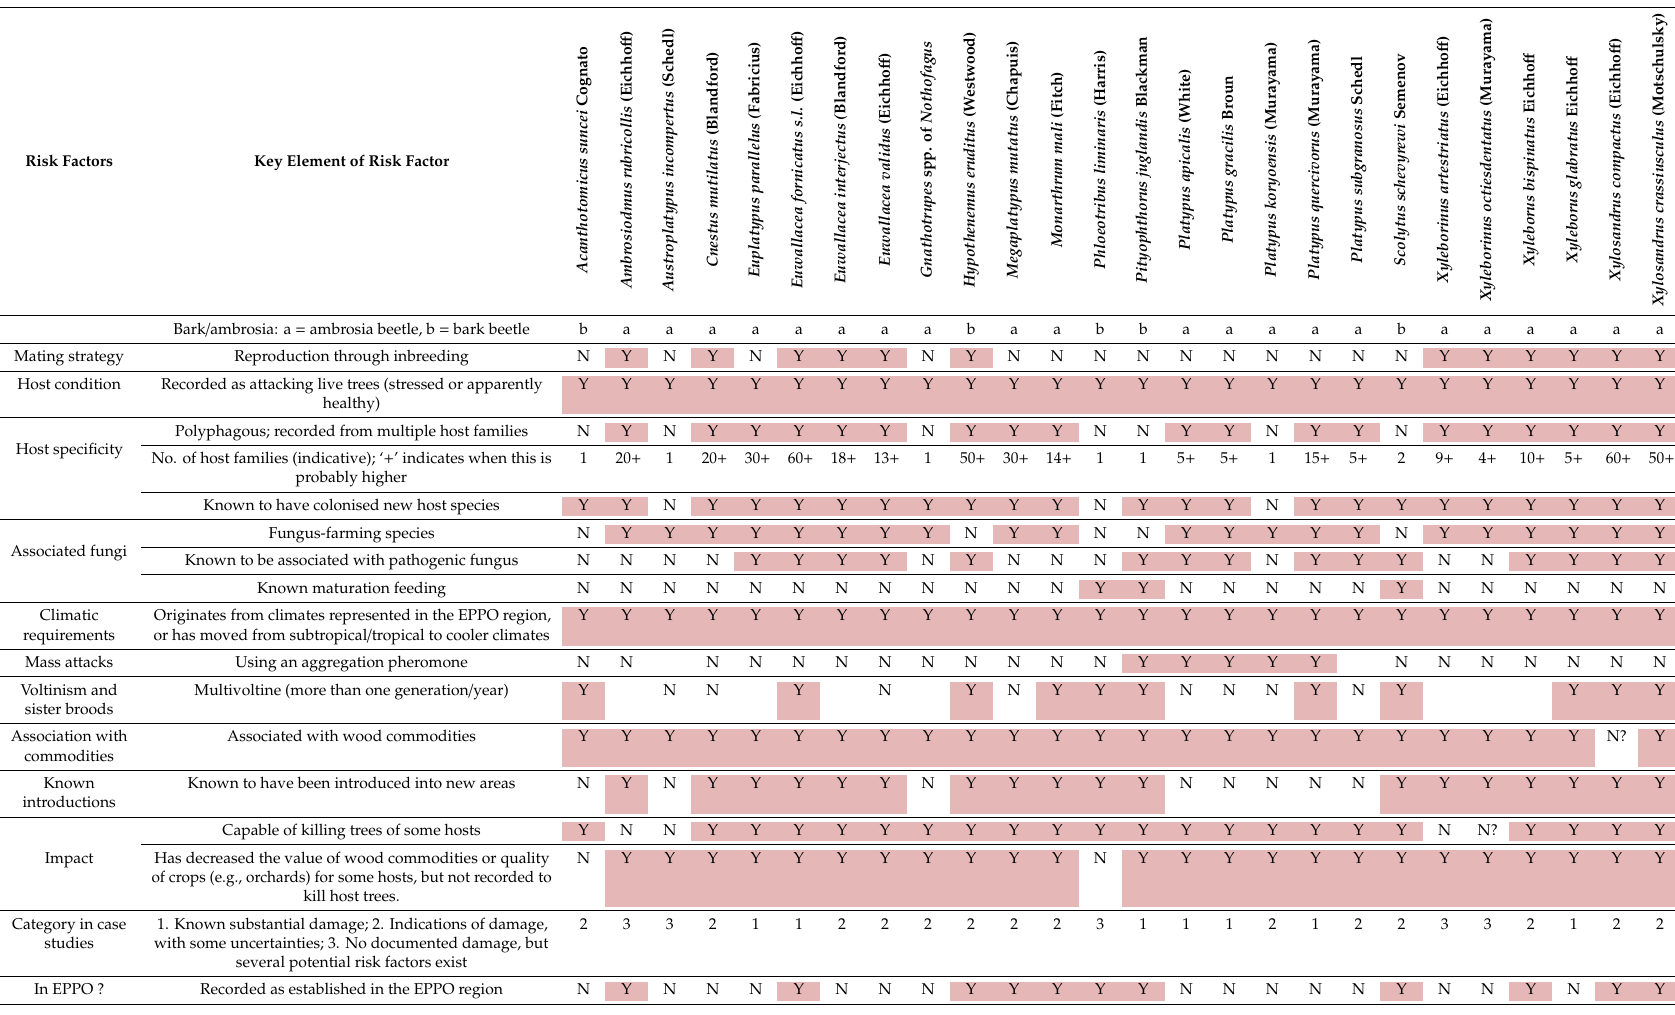
Table 2. Rating of risk factors for the 26 representative species and groups of species. Legend: s.l. = sensu lato ; Y = Yes; N = No; N? = doubt on the answer; Empty cell: no information